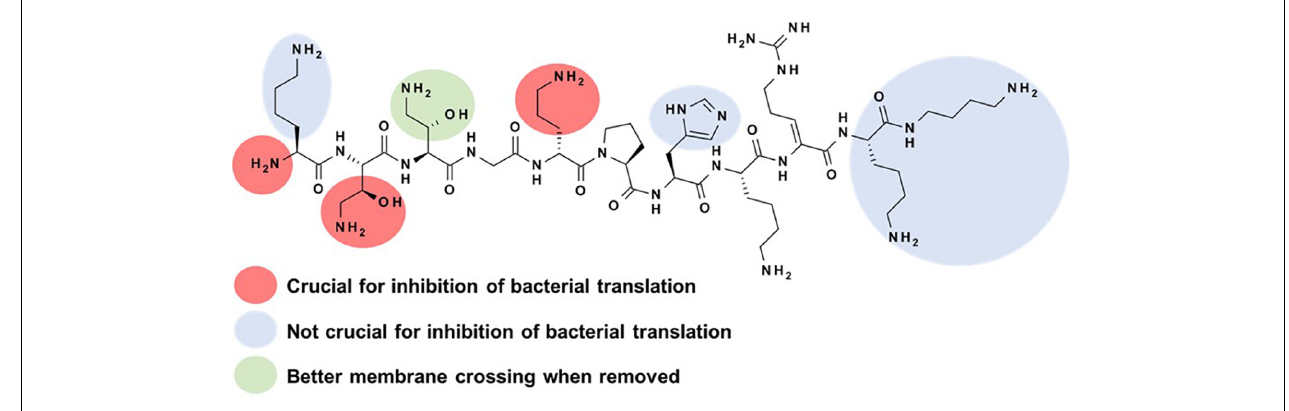
FIGURE 3 | Structure-activity relationships for the inhibition of bacterial translation by